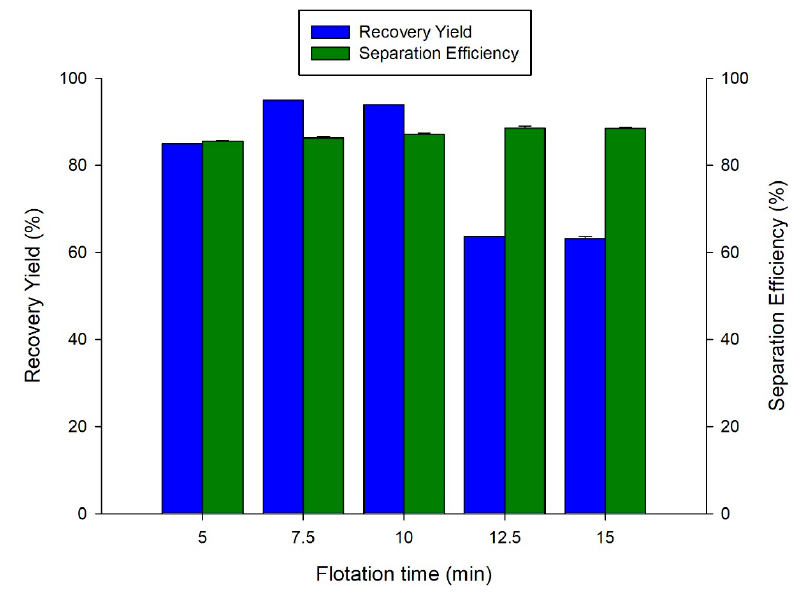
Figure 9. Figure illustrating the effect of flotation time on protein recovery yield and separation